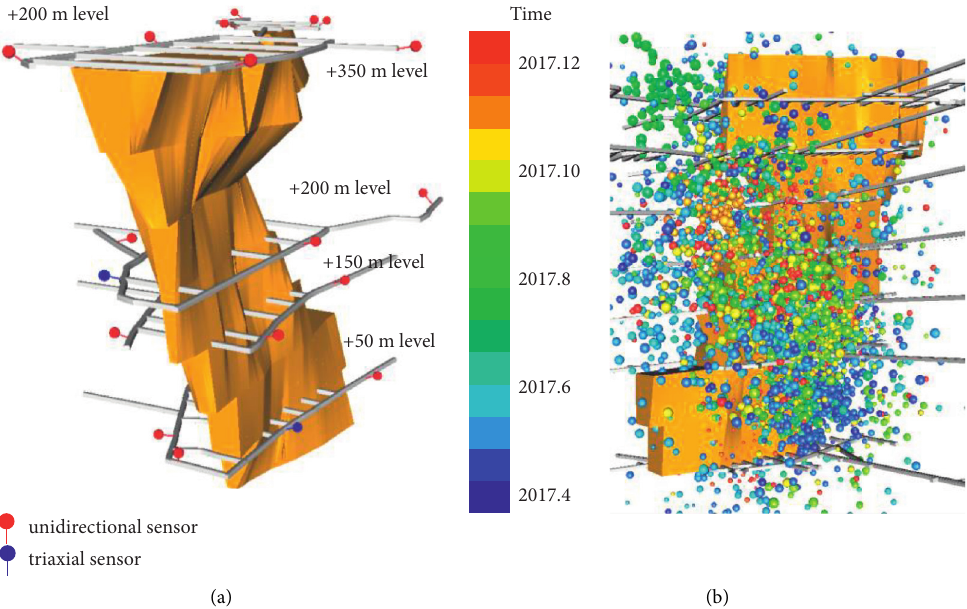
Figure 1: (a) Layout of sensors [50] and (b) spatial distribution of microseismic events in the deep mining area.